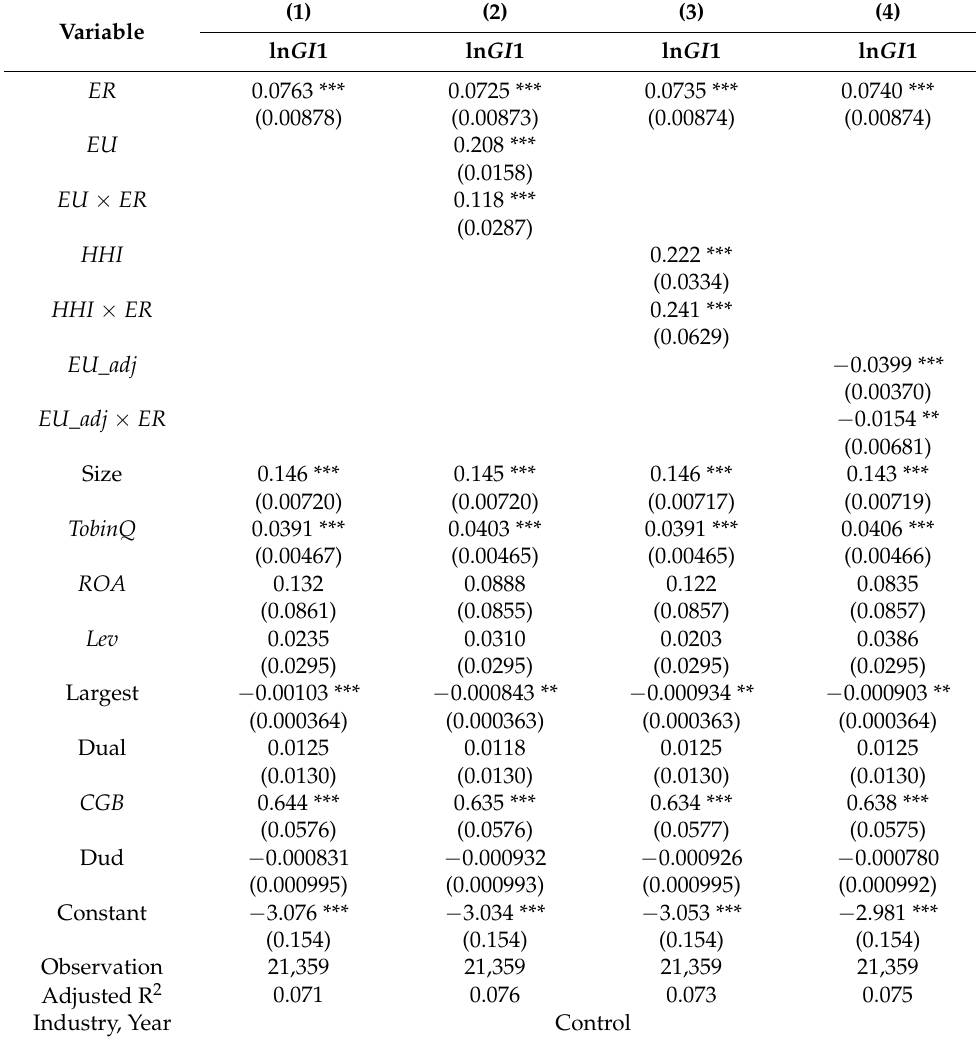
Table A2. Robustness Analysis of Environmental Uncertainty, Environmental Regulation and Enter- prises’ Green Technological Innovation.